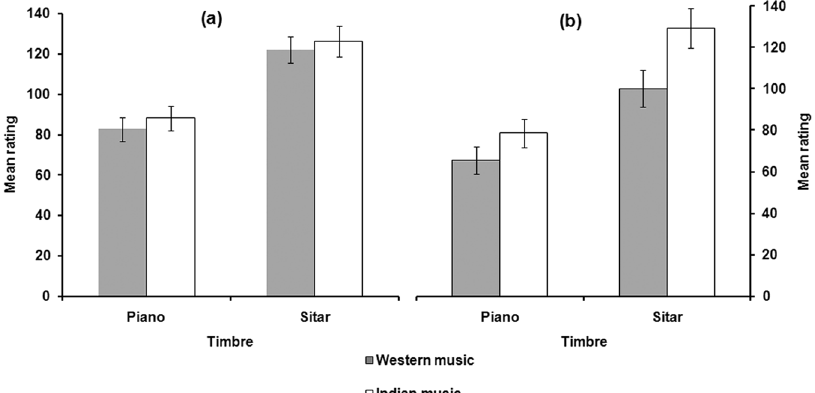
Figure 1. Tension judgment for the Western-piano, Western-sitar, Indian-piano, and Indian-sitar conditions by amusics ( a ) and controls ( b ). Error bars indicate standard